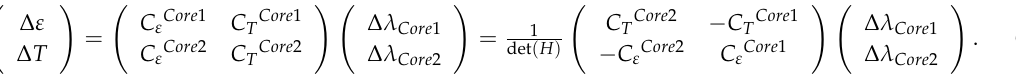
Figure 16. ( a ) Microscope image of a 7-core optical sensing fiber; ( b ) Schematic diagram of MCF-based sensing device structure [138].